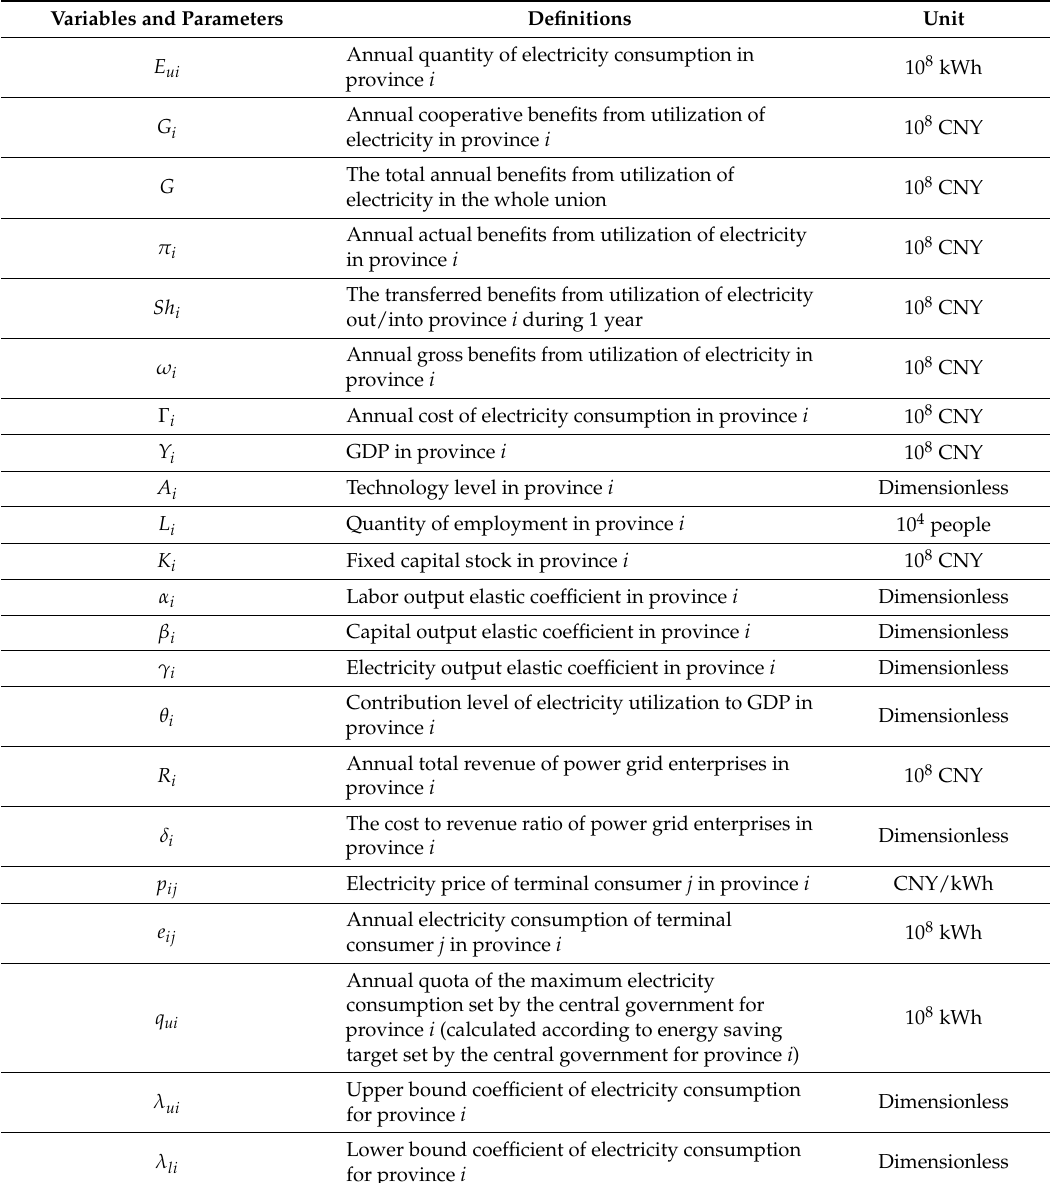
Table 1. Definitions of variables and